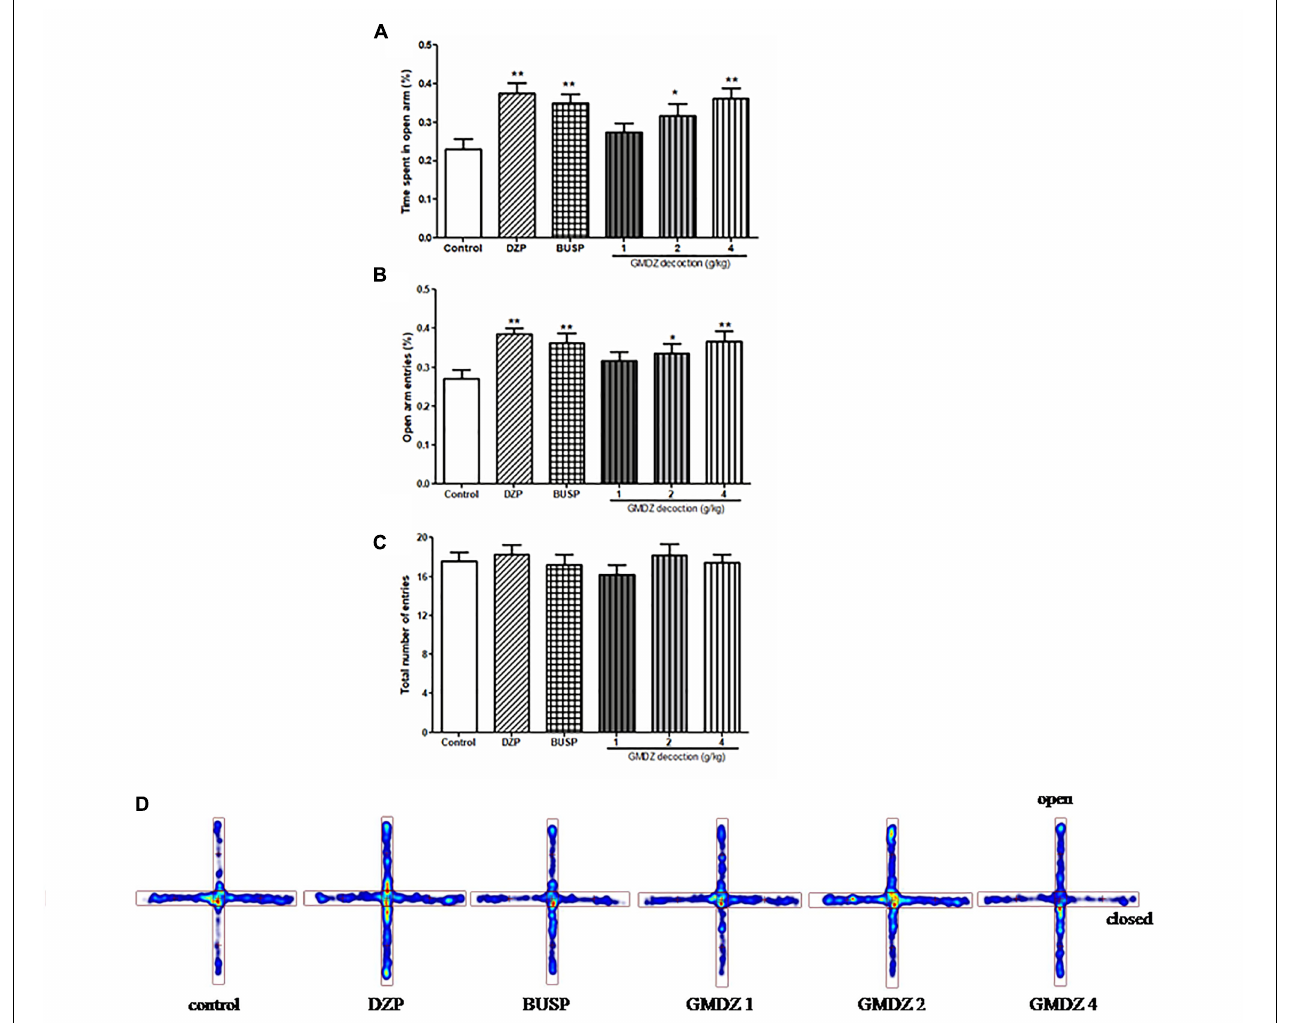
FIGURE 2 | Effect of GMDZ decoction on the EPM test (A) The percentage of time spent on open arms. (B) The percent of open arms entries. (C) The total arm entries. (D) Representative heat map analysis of one animal in each group. Value are represented as mean ± SEM ( n = 12). ∗∗ P < 0.01 vs. control group. One